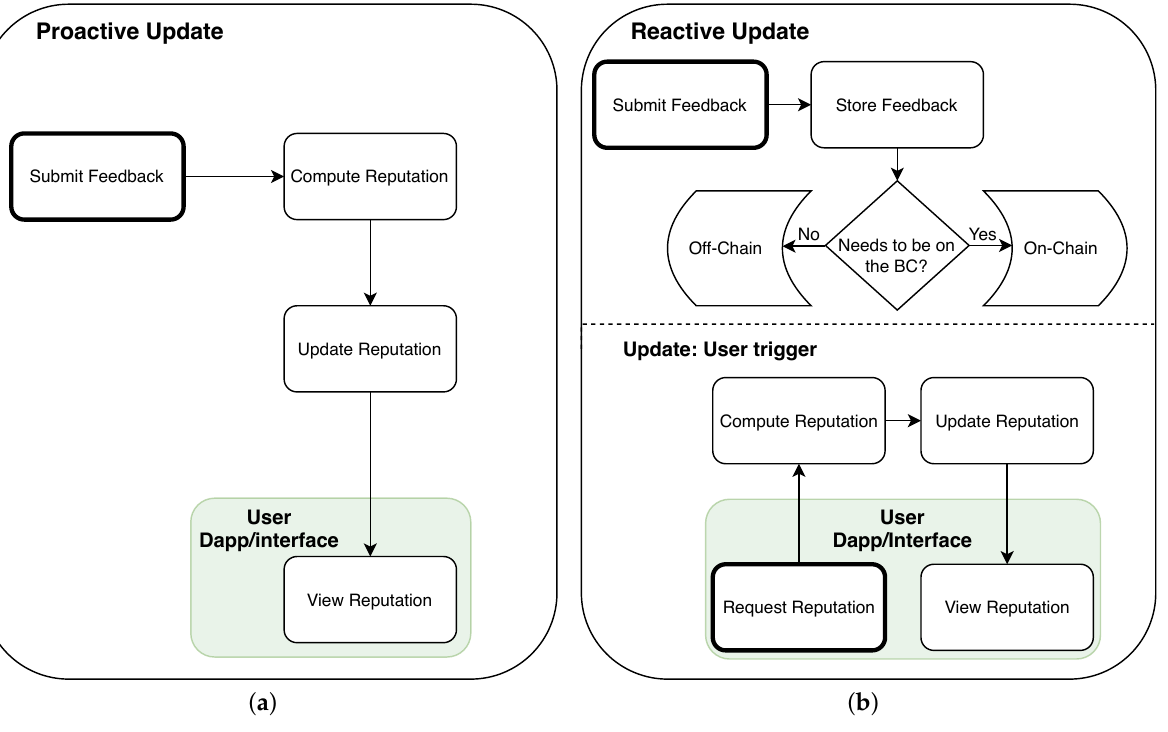
Figure 6. Proactive and Reactive Updates